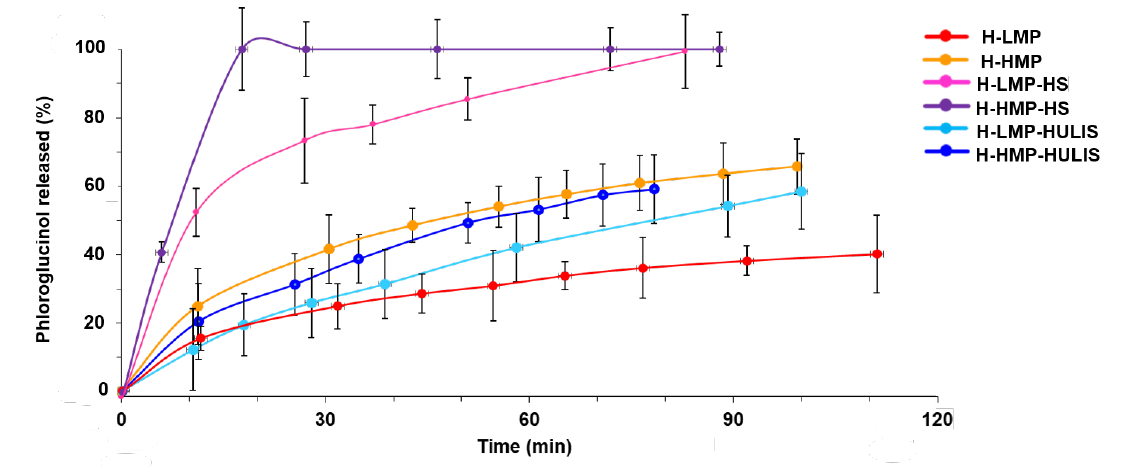
Figure 6. Percent of phloroglucinol released with time from hydrogels in aqueous medium. Table 2. Kinetic parameters of phloroglucinol released from hydrogels using the Korsmeyer-Peppas